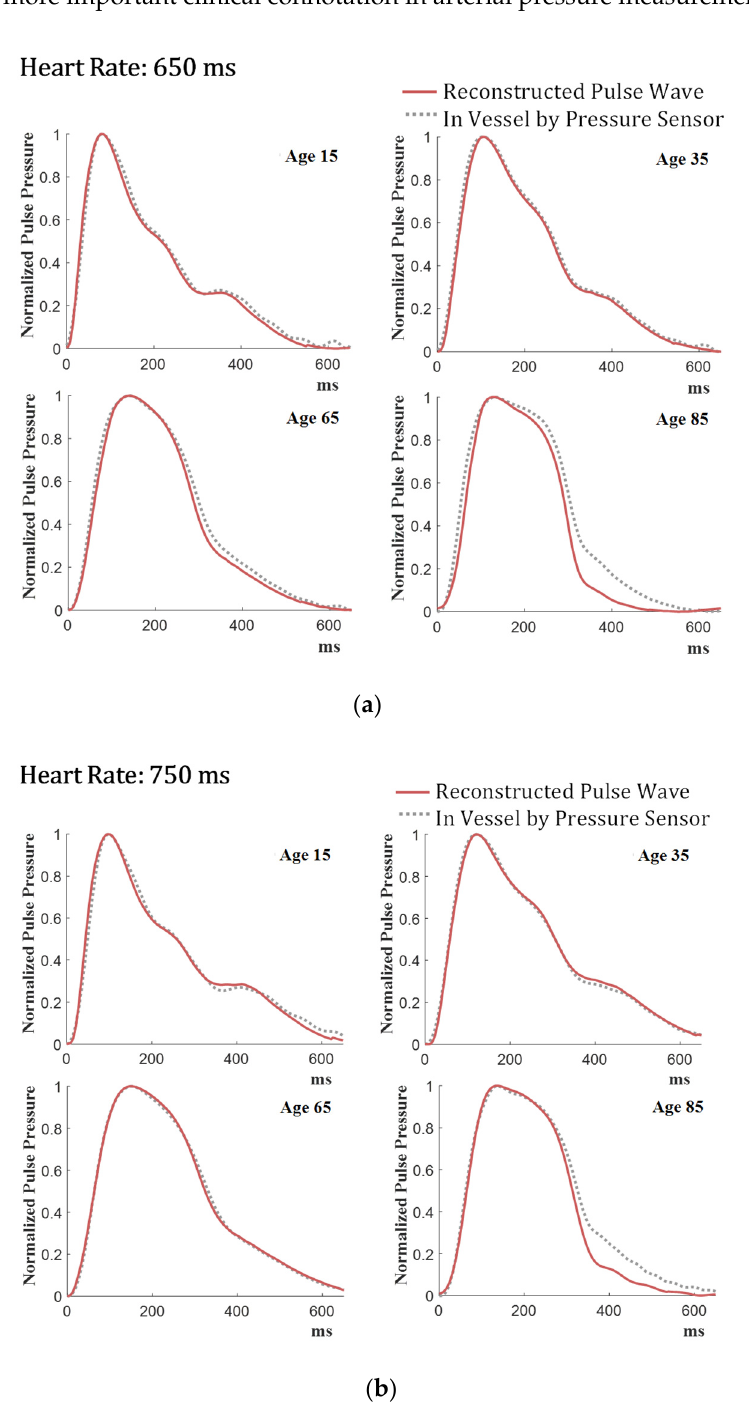
Figure 10. Comparison between the normalized reconstructed pulse waveforms and intravascular waveforms: ( a ) 650 ms heart rate, ( b ) 750 ms heart rate. waveforms: ( a ) 650 ms heart rate, ( b ) 750 ms heart